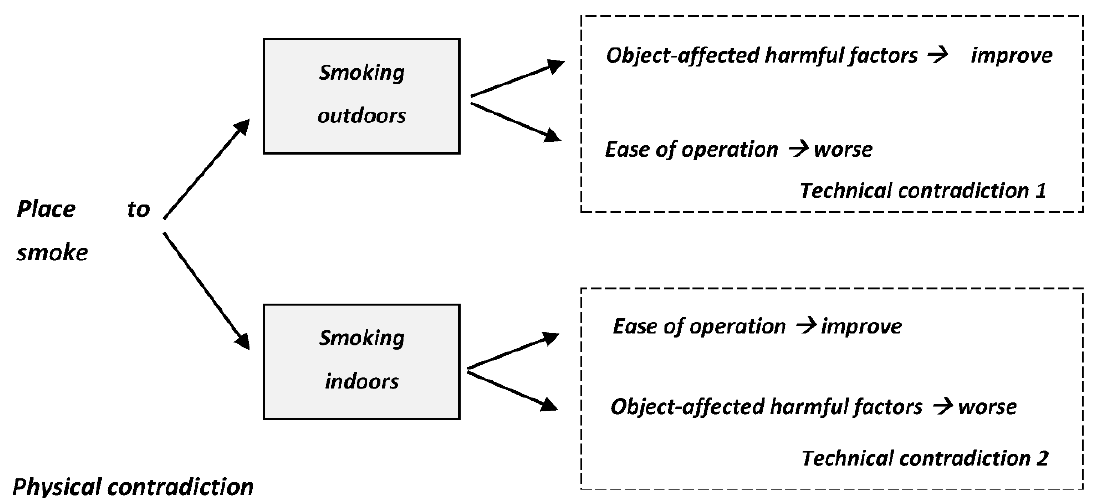
Figure 2. Technical contradiction expressed through the technical parameters of Altshuller Matrix.